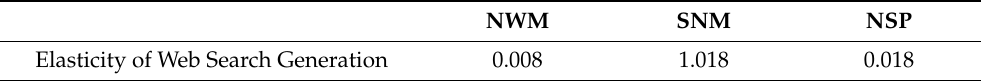
Table 4. Elasticity of marketing activities for web search